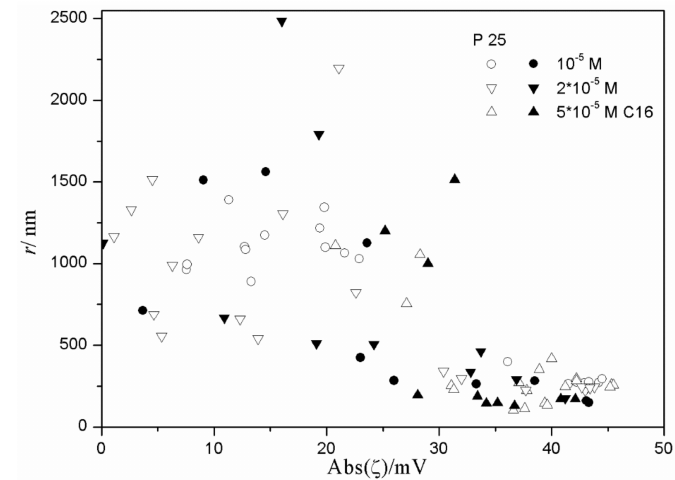
Figure 13. The particle size as a function of | ζ | in fresh (white points) and aged (black points) dispersions of titania in the presence of sodium hexadecylsulfate.